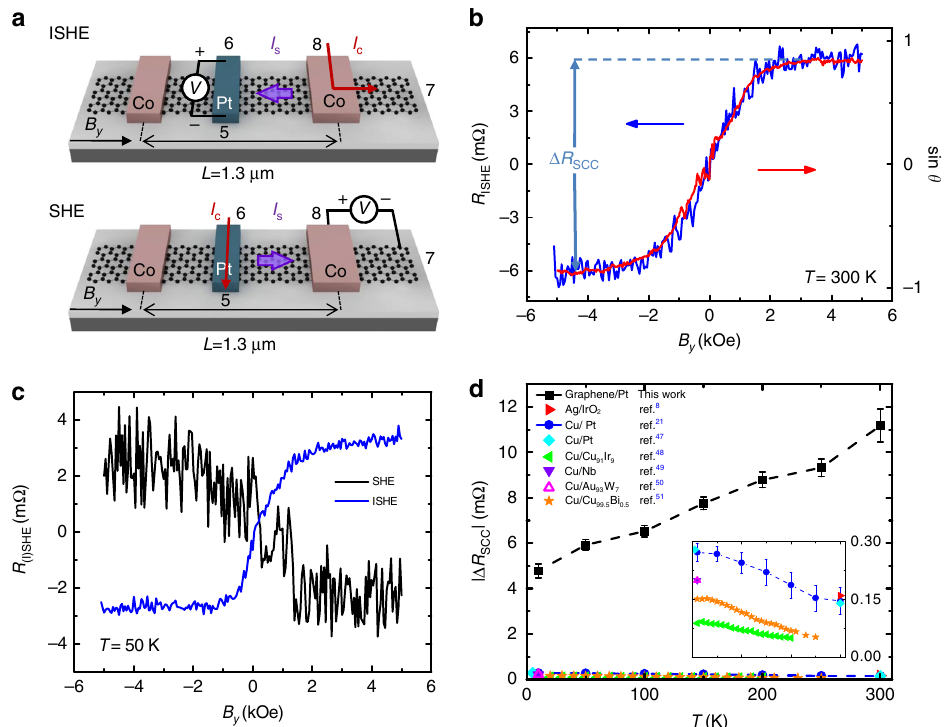
Fig. 4 Spin-to-charge conversion in a trilayer graphene/Pt lateral heterostructure. a Sketch of the ISHE ( top ) and the SHE ( bottom ) measurement con fi gurations, including the electrodes from Fig. 1b that are used, and the direction of the applied magnetic fi eld ( B y ). b ISHE resistance ( blue ) as a function of B y measured with I C = 10 μ A at 300 K. A baseline signal of 6.5 m Ω , corresponding to the Ohmic contribution given by the van der Pauw currents spreading into the voltage detector, has been subtracted. For comparison, sin θ ( red ) as a function of B y extracted from the Hanle measurement is also shown. The spin-to-charge conversion signal Δ R SCC is tagged. c The ISHE ( blue ) and SHE ( black ) resistance as a function of B y measured with I C = 10 μ A at 50 K in the con fi gurations sketched in a with center-to-center Co electrode spacing L = 1.3 μ m, showing the reciprocity of the two effects. A baseline signal of 4 m Ω (7 m Ω ), corresponding to the Ohmic contribution, has been subtracted from the ISHE (SHE) curve. d Experimental values of Δ R SCC at different temperatures measured in the graphene/Pt heterostructure. Literature values of Δ R SCC of various spin Hall metals employing different metallic spin channels are also included for comparison: Ag/IrO 2 8 , Cu/Pt 21, 48 , Cu/Cu 91 Ir 9 49 , Cu/Nb 50 ), Cu/Au 93 W 7 51 ) and Cu/Cu 99.5 Bi 0.5 52 . Inset: Zoom of the main plot showing the data of the devices with metallic spin channels. Error bars are calculated using the standard errors associated with the statistical average of the nonlocal resistance at positive and negative saturated magnetic fi